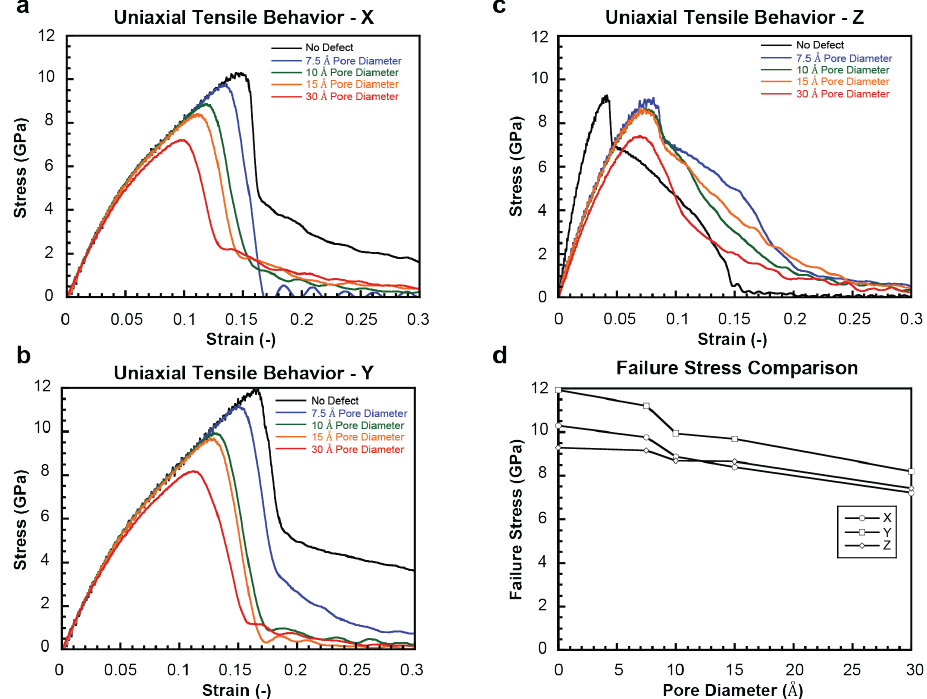
Figure 1. Effect of pore inclusion on HAP tensile mechanical response. ( a – c ) X, Y, and Z direction stress–strain curves for monocrystalline HAP with and without pores of different sizes, respectively. ( d ) Measured failure stress for each loading direction as a function of pore